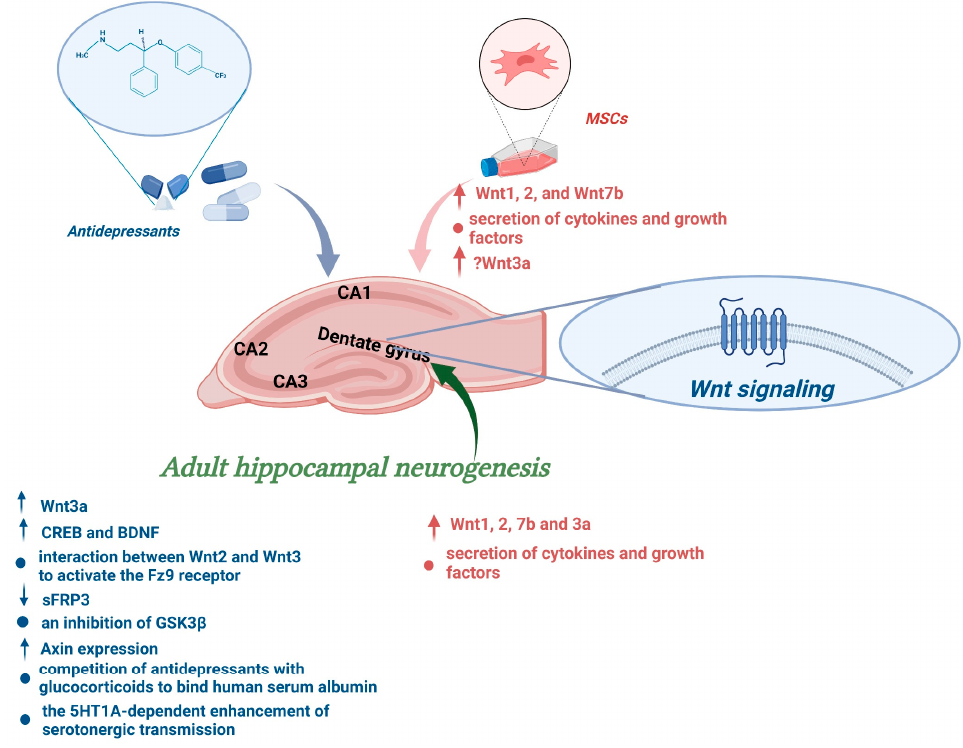
Figure 3. Influence of antidepressants and mesenchymal stem cells on adult hippocampal neurogenesis via the Wnt signaling pathway ( The figure was made in Biorender ).